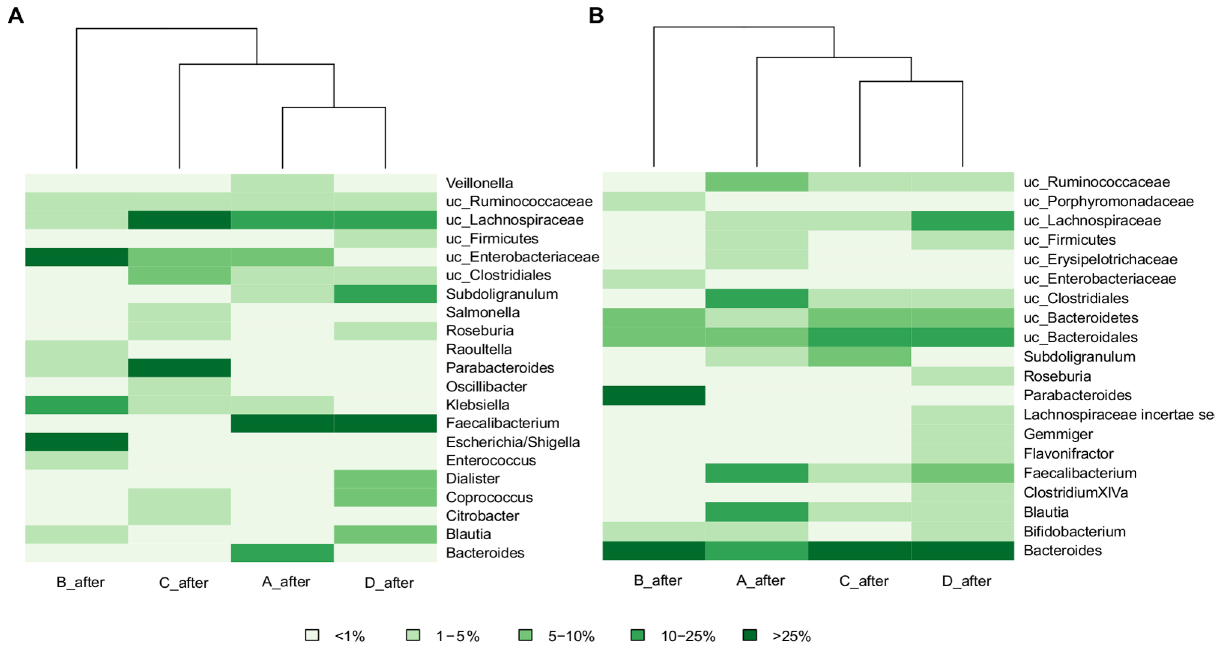
Figure 2. Heat map and clustering based on taxon composition and abundance. (A) total microbiota, (B) active microbiota. Colors in the figure depict the percentage range of sequences assigned to main taxa (abundance . 1% in at least one